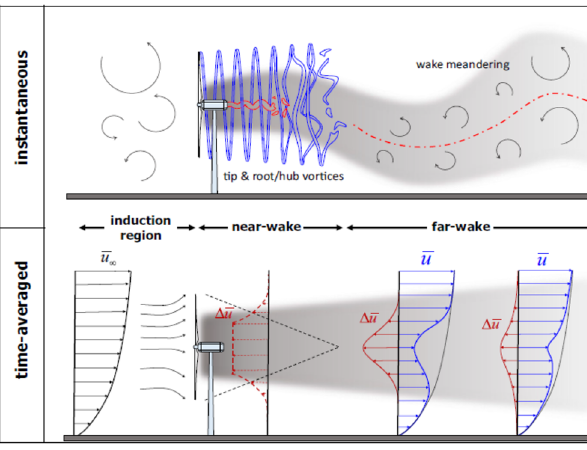
Fig. 2. Schematic representation of the two discrete wake regions downstream a WT ’ s